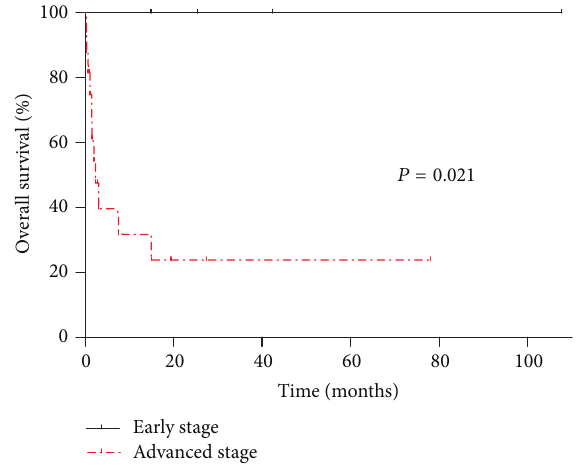
Figure 1: The probability of overall survival for early and advanced stage lung cancer.